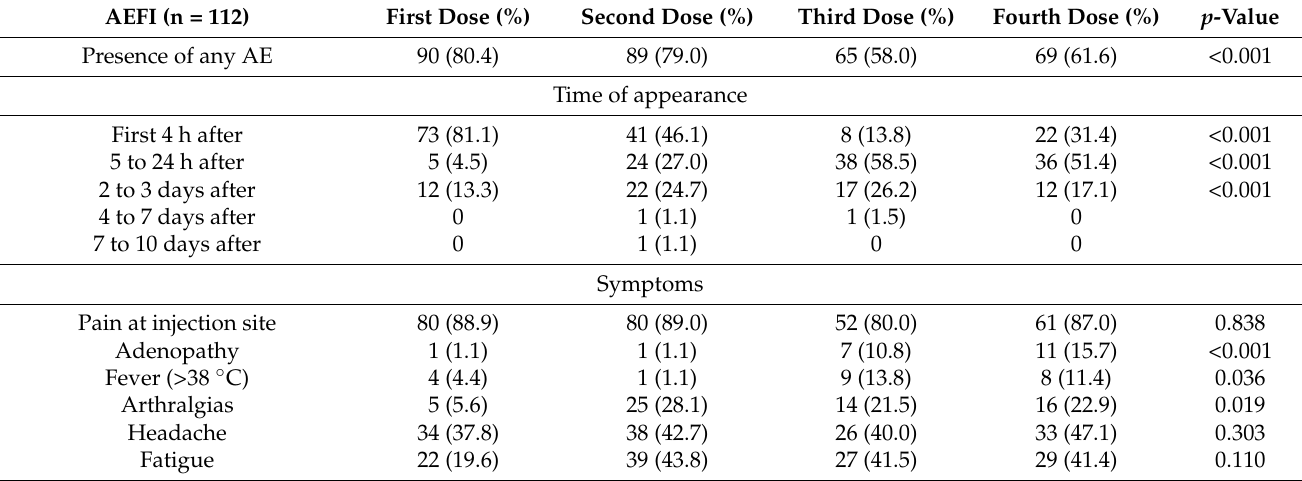
Table 3. Adverse events following immunization after each administered BNT162b2